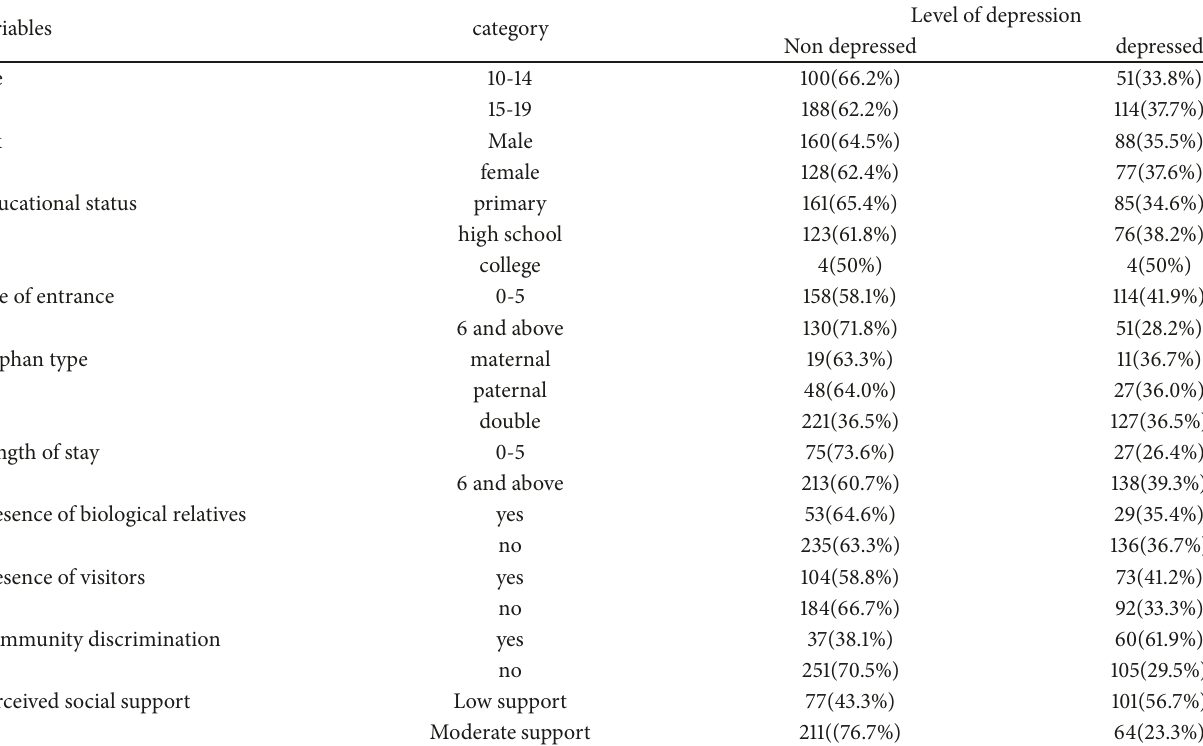
Table 2: Distribution of depression prevalence among orphan adolescents in Addis Ababa orphan centers, Addis Ababa, Ethiopia, 2016 (N=453).